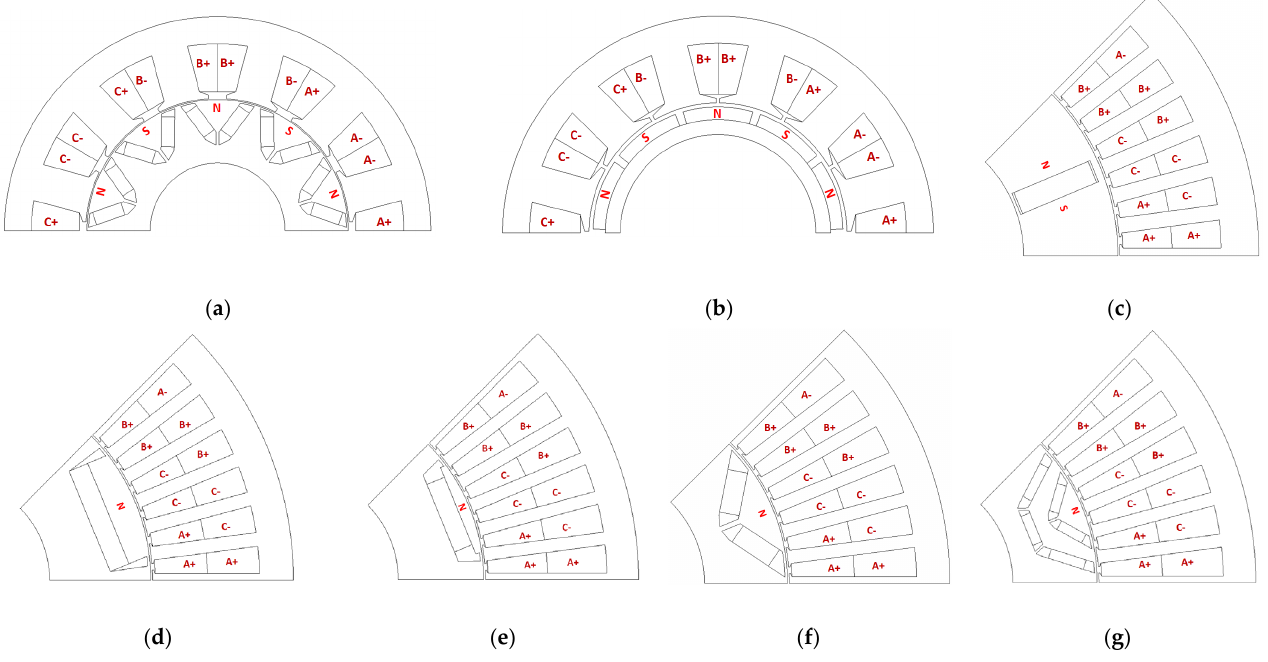
Figure 2. Cross-sectional views of seven baseline PM machines: ( a ) 12-slot/10-pole FSCW-IPM; ( b ) 12-slot/10-pole FSCW- SPM; ( c ) 48-slot/8-pole DW-IPM (spoke type); ( d ) 48-slot/8-pole DW-IPM (Flat 1); ( e ) 48-slot/8-pole DW-IPM (Flat 2); ( f ) 48-slot/8-pole DW-IPM (V shape); ( g ) 48-slot/8-pole DW-IPM (VU